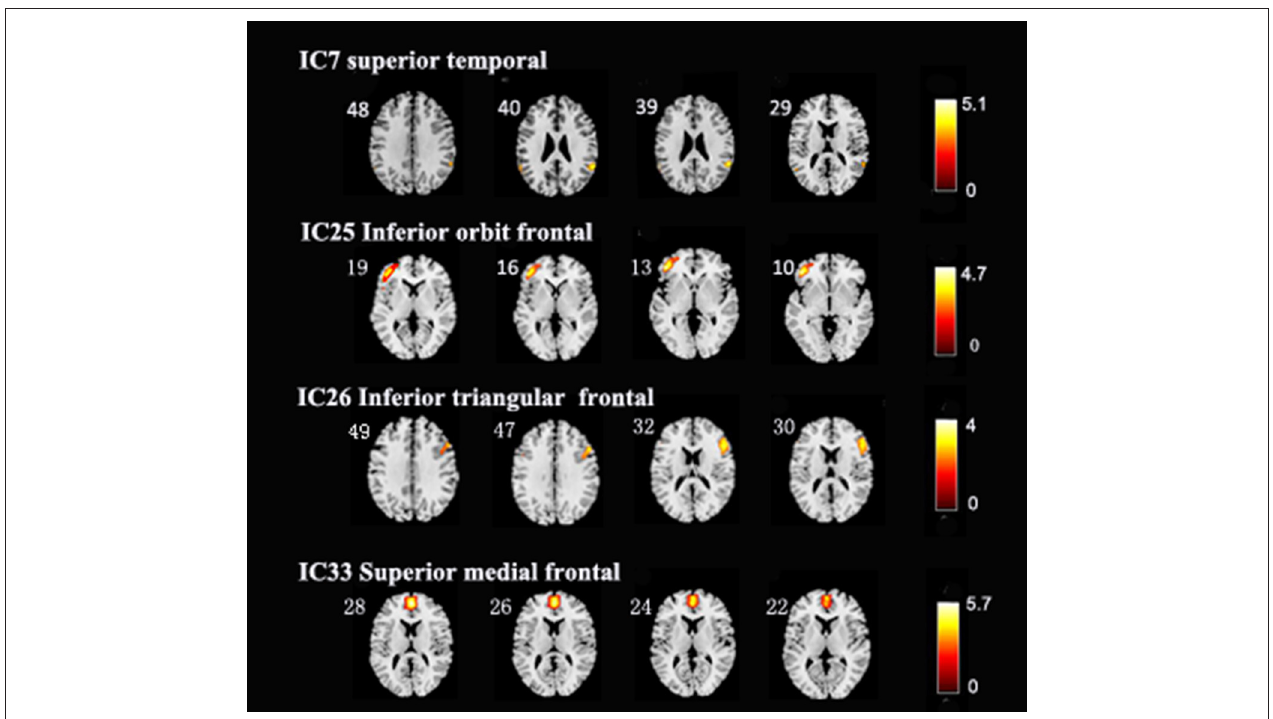
FIGURE 2 | In the three intrinsic networks, four regions, namely, inferior orbit frontal gyrus (L) in frontoparietal network (IC25), triangle inferior frontal gyrus(R) in central executive network (IC26), superior temporal (R), and frontal superior medial gyrus (L) in the default mode network (IC7, IC33) showed significant activity discrepancy across three groups (FWE, p < 0.05 corrected). TABLE 2 | Distinct regions extracted from brain intrinsic networks. IC Voxel size